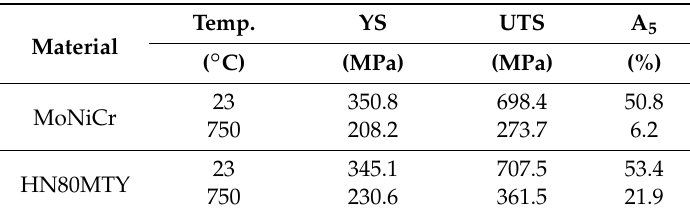
Table 3. Mechanical properties of nickel ‐ based alloys.